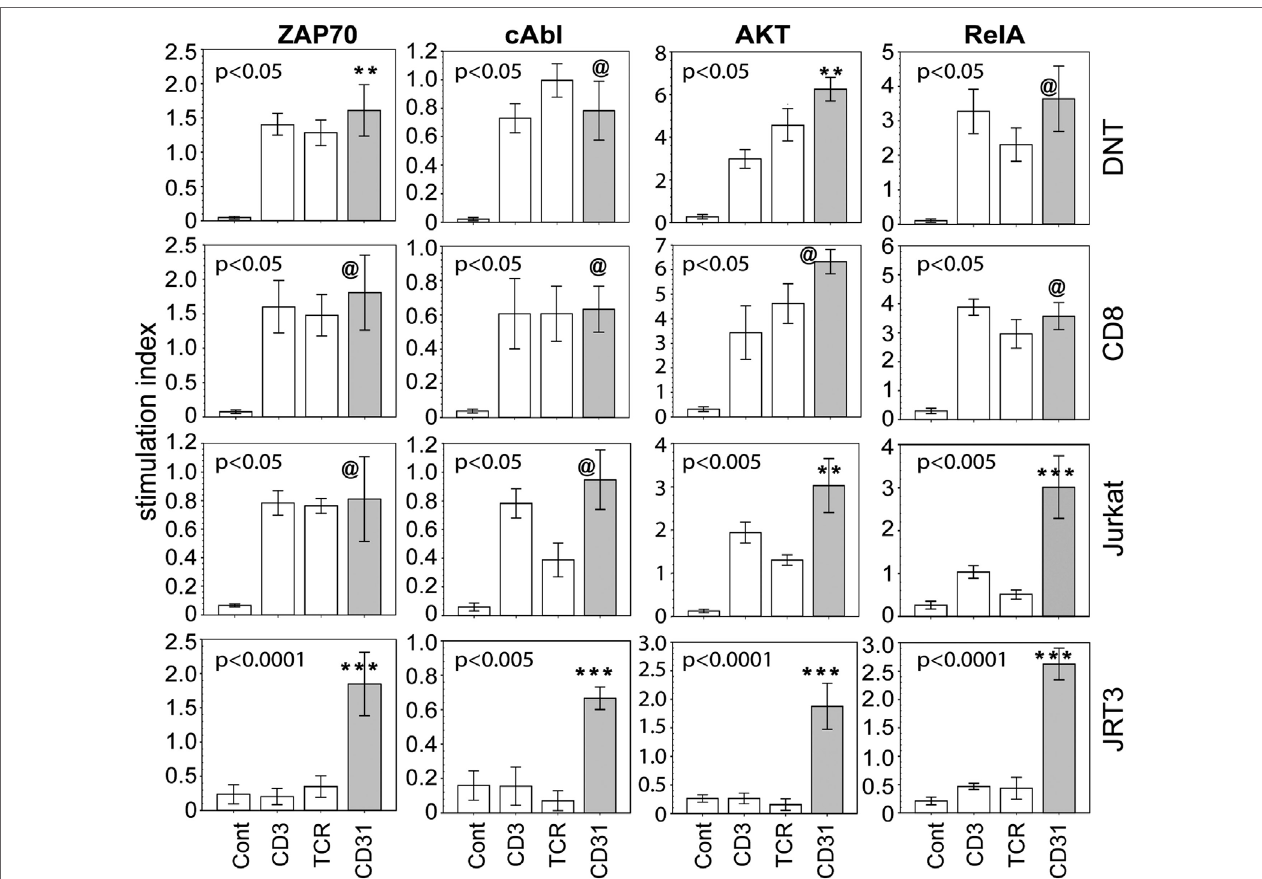
FigUre 4 | CD31 ligation alone is sufficient to elicit phosphorylation of signaling intermediates. Using the same crosslinking bioassay in Figure 3a , the data shown (bar means, SD whiskers; n = 5–9 per group) are phosphorylation levels of ZAP70, cAbl, AKT, and RelA within 15 min of stimulation via CD31, TCR, CD3, or IgG control. The data are normalized stimulation indices as in Figure 3B . The indicated P -values were determined by Kruskal–Wallis ANOVA. Post hoc group comparisons by Tukey: [***] and [**] P < 0.005 and P < 0.05, respectively, indicate CD31 crosslinking was significantly different from TCR or CD3 crosslinking or the IgG control [Cont]; [@] indicates CD31 crosslinking was not significantly different from TCR or CD3 crosslinking, but was significantly different ( P = 0.0001) from the IgG